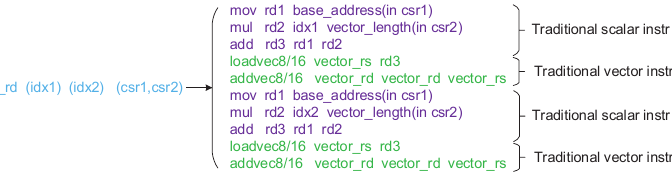
Figure 11. Another load-rs-add-rd-vec8/16 instruction equivalent.